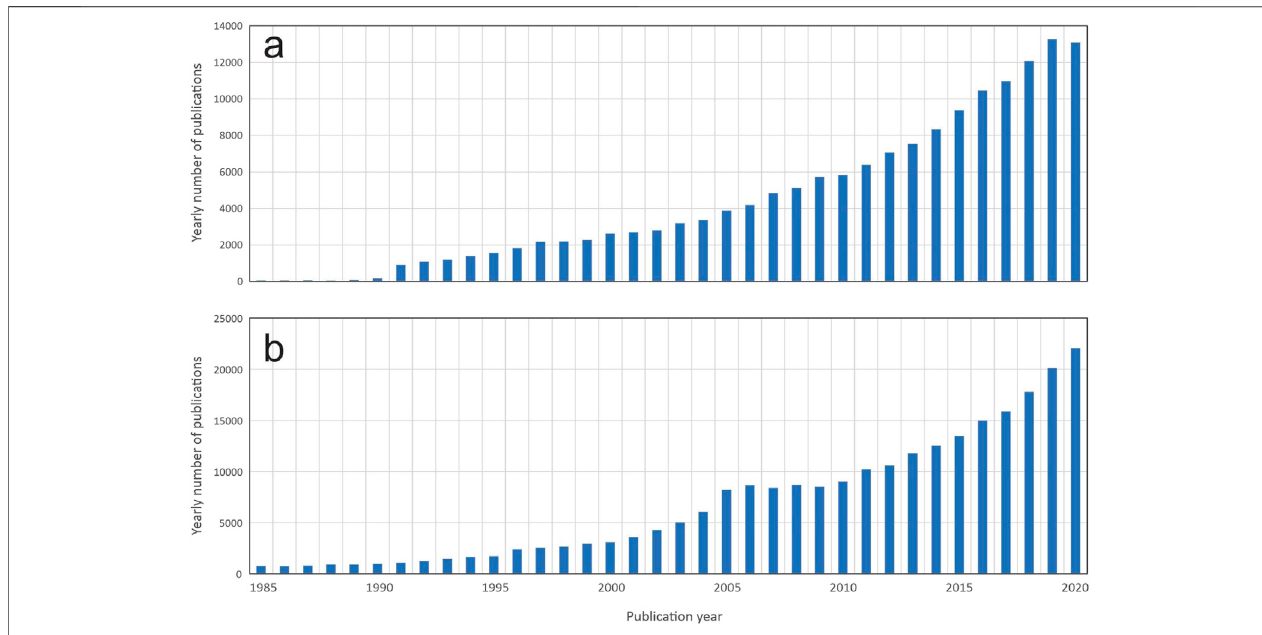
FIGURE 1 | Yearly number of publications with the keyword “ time series analysis ” per year during 1985 – 2020 from WoS (A) and Scopus (B) database.